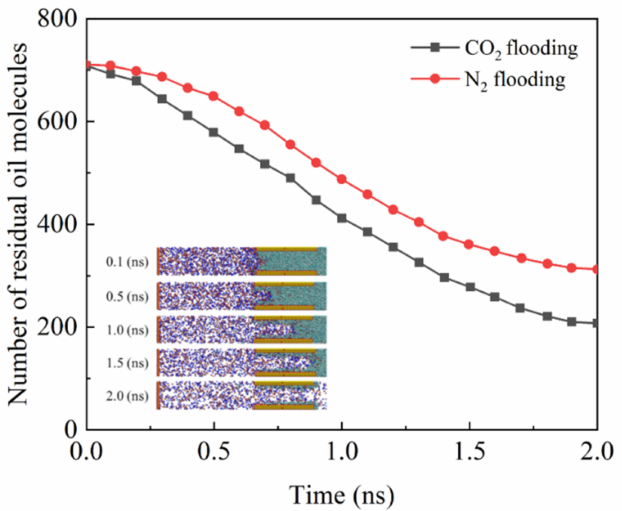
Figure 12. Evolutions of CO 2 and N 2 flooding from 0 to 2ns; with residual oil molecules in nano- slits [136]. (For in-depth interpretation of these data, the readers are referred to Fang et al. paper